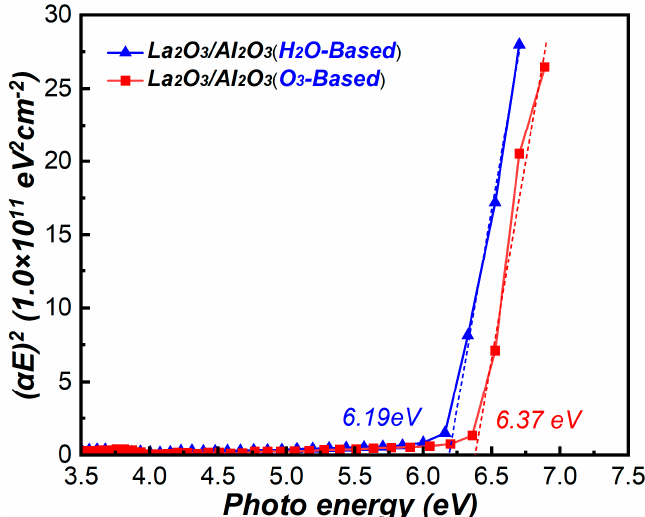
Figure 8. ( α E ) 2 versus photo energy E of La 2 O 3 /Al 2 O 3 nanolaminates. Using the calculated VBO and band gap values, the conduction band offset between La 2 O 3 /Al 2 O 3 nanolaminates and MoS 2 can be attained by the following equation: ∆𝐸 (cid:3004)(cid:3003)(cid:3016) = 𝐸 (cid:3034)(cid:2896)(cid:2911) (cid:3118) (cid:2899) (cid:3119) /(cid:2885)(cid:2922) (cid:3118) (cid:2899) (cid:3119) (cid:2924)(cid:2911)(cid:2924)(cid:2925)(cid:2922)(cid:2911)(cid:2923)(cid:2919)(cid:2924)(cid:2911)(cid:2930)(cid:2915)(cid:2929) - 𝐸 (cid:3034)(cid:3014)(cid:3042)(cid:3020) (cid:3118) − ∆𝐸 (cid:3023)(cid:3003)(cid:3016) (2) where 𝐸 (cid:3034)(cid:2896)(cid:2911) (cid:3118) (cid:2899) (cid:3119) /(cid:2885)(cid:2922) (cid:3118) (cid:2899) (cid:3119) (cid:2924)(cid:2911)(cid:2924)(cid:2925)(cid:2922)(cid:2911)(cid:2923)(cid:2919)(cid:2924)(cid:2911)(cid:2930)(cid:2915)(cid:2929) and 𝐸 (cid:3034)(cid:3014)(cid:3042)(cid:3020) (cid:3118) is the bandgap of La 2 O 3 /Al 2 O 3 nanolaminates and MoS 2 , respectively. The bandgap of 1.4 eV for MoS 2 is used here [27]. According to the Equation (2), the CBO of O 3 -based La 2 O 3 /Al 2 O 3 nanolaminates on MoS 2 and MoS 2 with